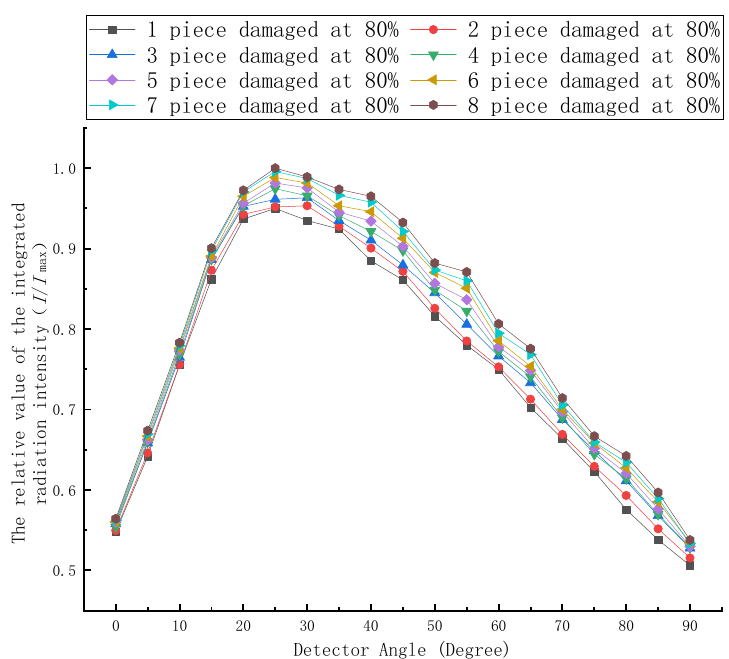
Figure 20. Radiation intensity curves of 80% damaged adjusting plates at different positions. Finally, the influence of the number of damaged adjusting plates on the overall in- frared radiation intensity of the coating was studied. The calculation results are presented in Figure 21.